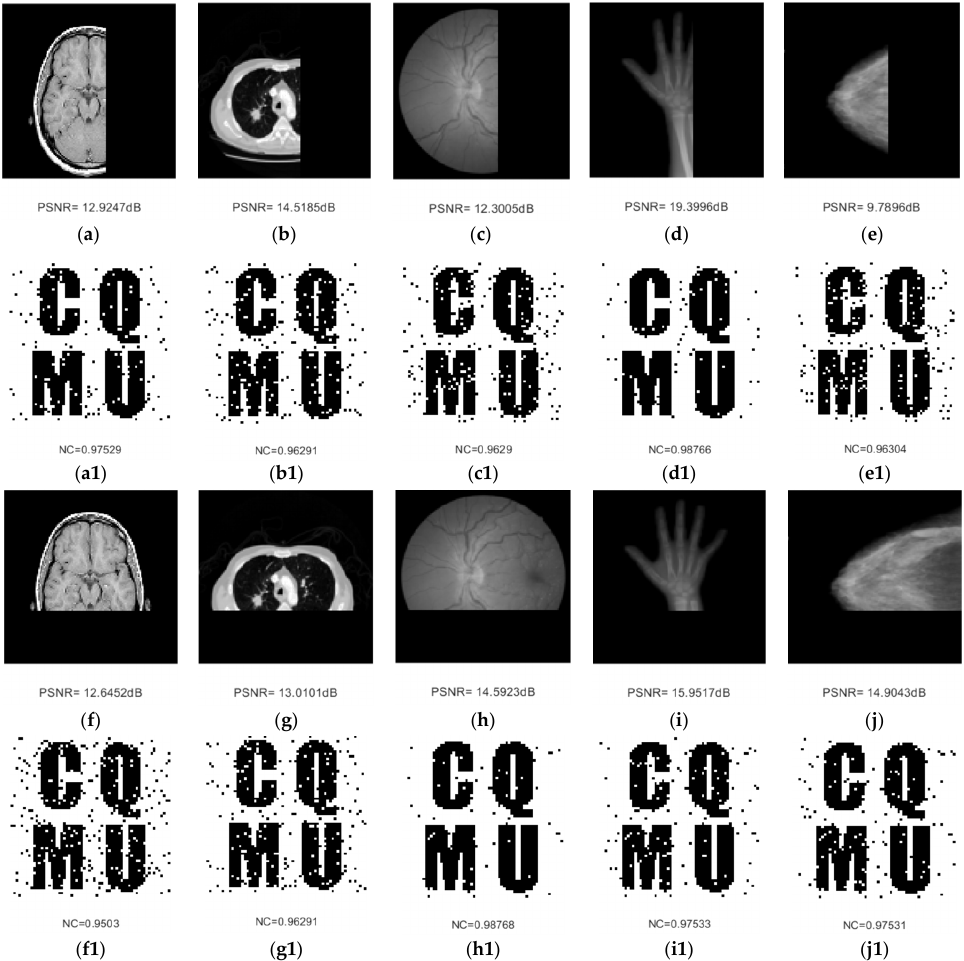
Figure 14. Attacked medical images and restored watermarking images under X-axis cropping 40% and Y-axis cropping 30%: ( a , f , a1 , f1 ) brain and extracted watermarking image; ( b , g , b1 , g1 ) chest and extracted watermarking image; ( c , h , c1 , h1 ) fundus blood vessels and extracted watermarking image; ( d , i , d1 , i1 ) hand and extracted watermarking image; and ( e , j , e1 , j1 ) breast and extracted watermarking image. Table 6. The result under cropping attacks.